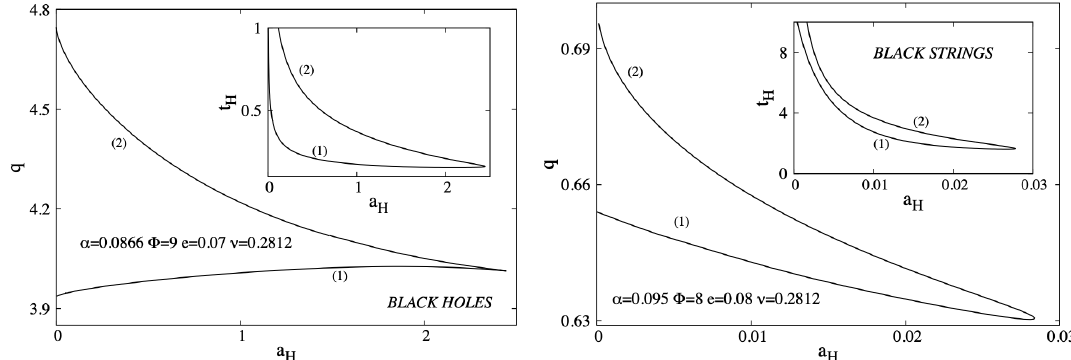
Figure 3 . The reduced electric charge and Hawking temperature are shown as a function of reduced horizon area for BHs and BSs. The quantities are shown in units set by the mass of the